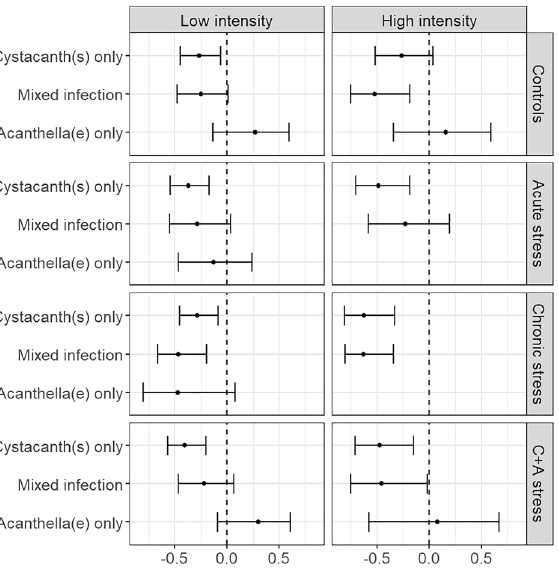
Figure 3. Effect sizes of refuge use of Gammarus fossarum for each infection status with Pomphorhynchus tereticollis compared to uninfected individuals in both experiments, separated by electric shock treatment. Points represent Cliff’s deltas and error bars represent confidence intervals. The effect sizes for the “acanthella(e) only” groups in the “acute stress” and “chronic stress” treatments in the “high intensity” experiment are not shown because the sample sizes were too low (N = 1). Positive values mean the focal group used the refuge more than uninfected individuals from the same treatment, and negative values mean they used it less. C + A: “chronic and